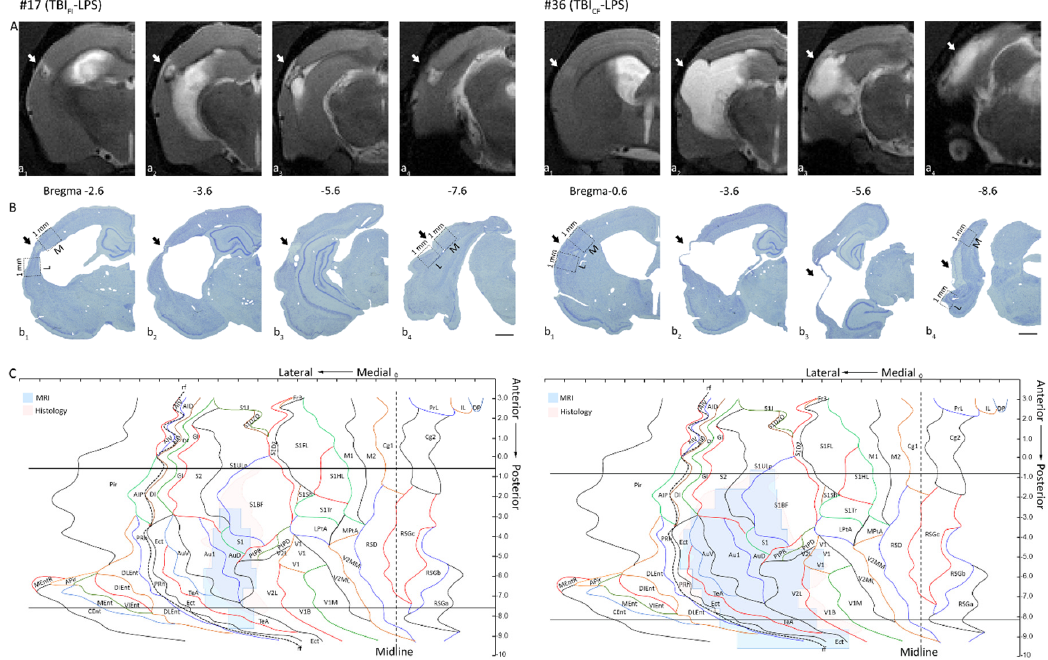
Figure 2. Cortical lesion endophenotypes. Representative unfolded MRI and histologic cortical maps of 2 rats with